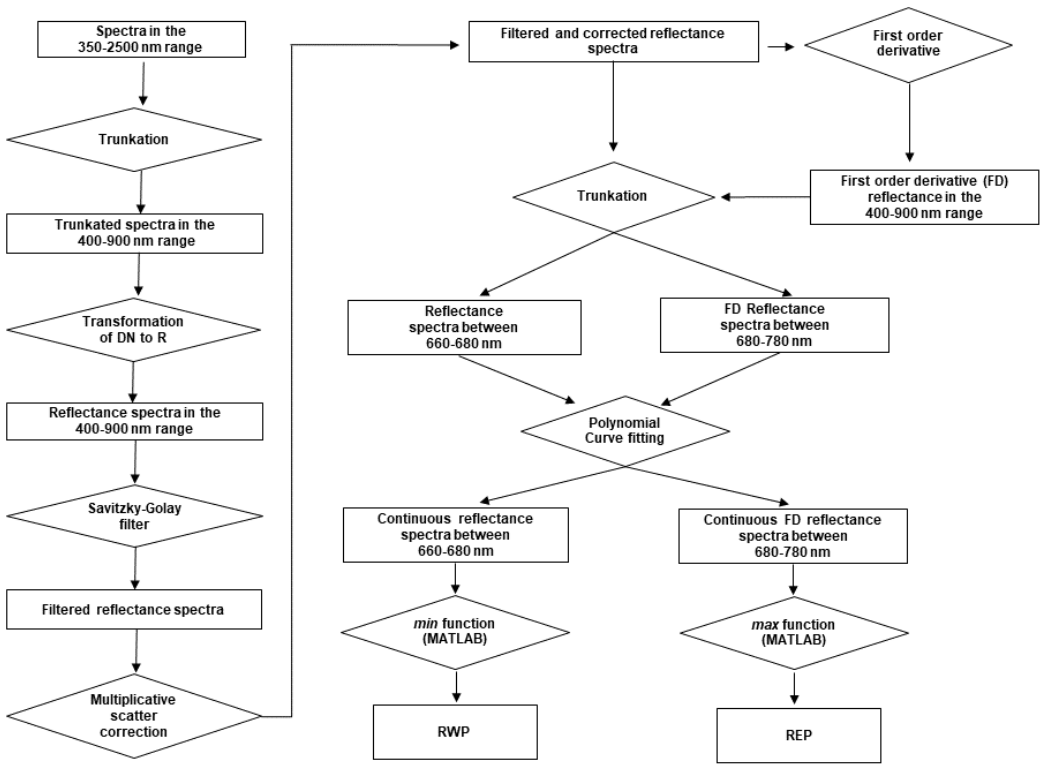
Figure 2. General workflow from the data collection to the computation of the red-well point (RWP) and the red-edge inflection point (REP).